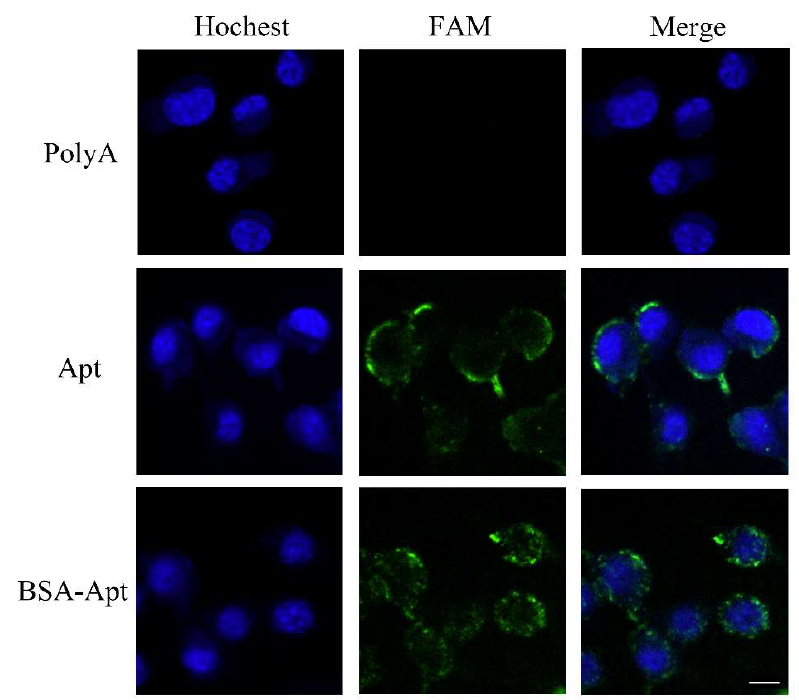
Figure 5. Confocal microscopy evaluation of CT26 cells stained by free PD-L1 aptamer or BSA-Apt. Green fluorescence signals were generated by FAM-labeled polyA, free PD-L1 aptamer, or BSA-Apt. The nuclei were stained blue with Hoechst. Bar represents 10 μm.